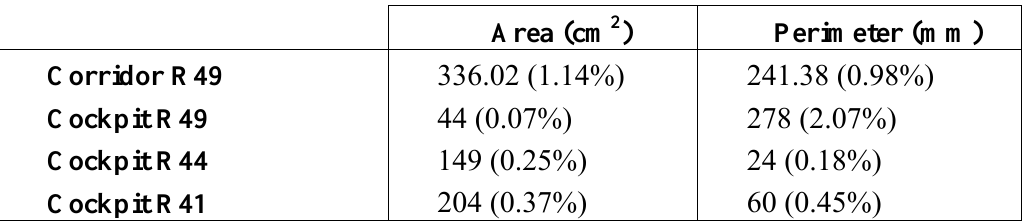
Table 1. Absolute and relative differences of the perimeters (mm) and areas (cm 2 ) in pieces of boat decks measured by both methods.